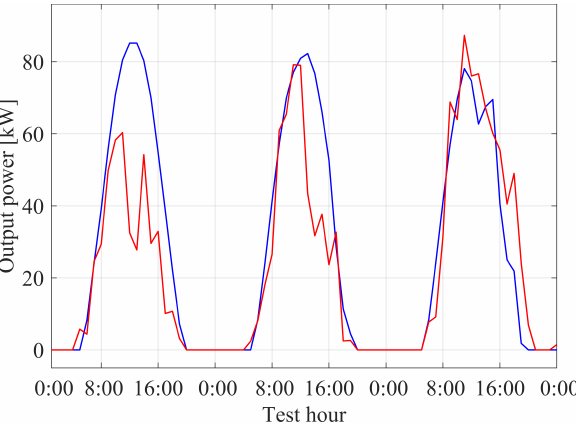
Figure 5. Predicted (red) and real (blue) value of output power in the mid of June 2018 by using the 2D-CNN approach with all the time series on 3-day test set (see Table 5, row 18, column 2).